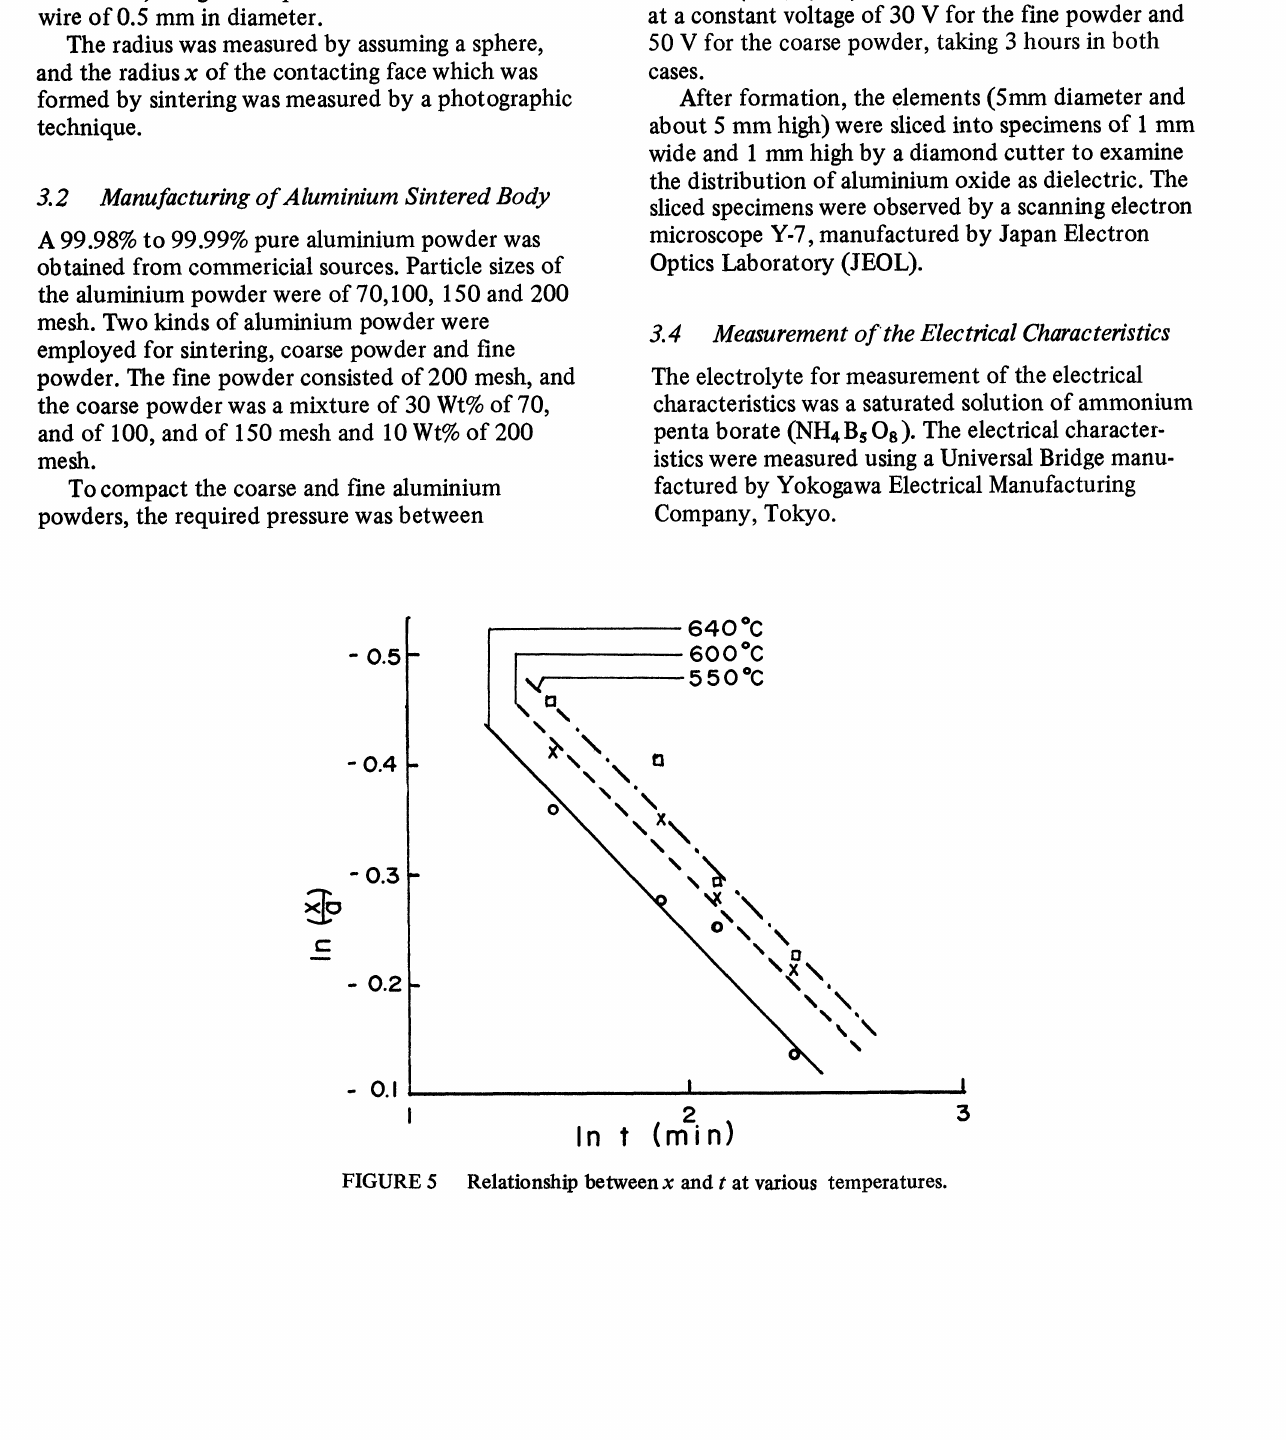
Relationship between x and at various